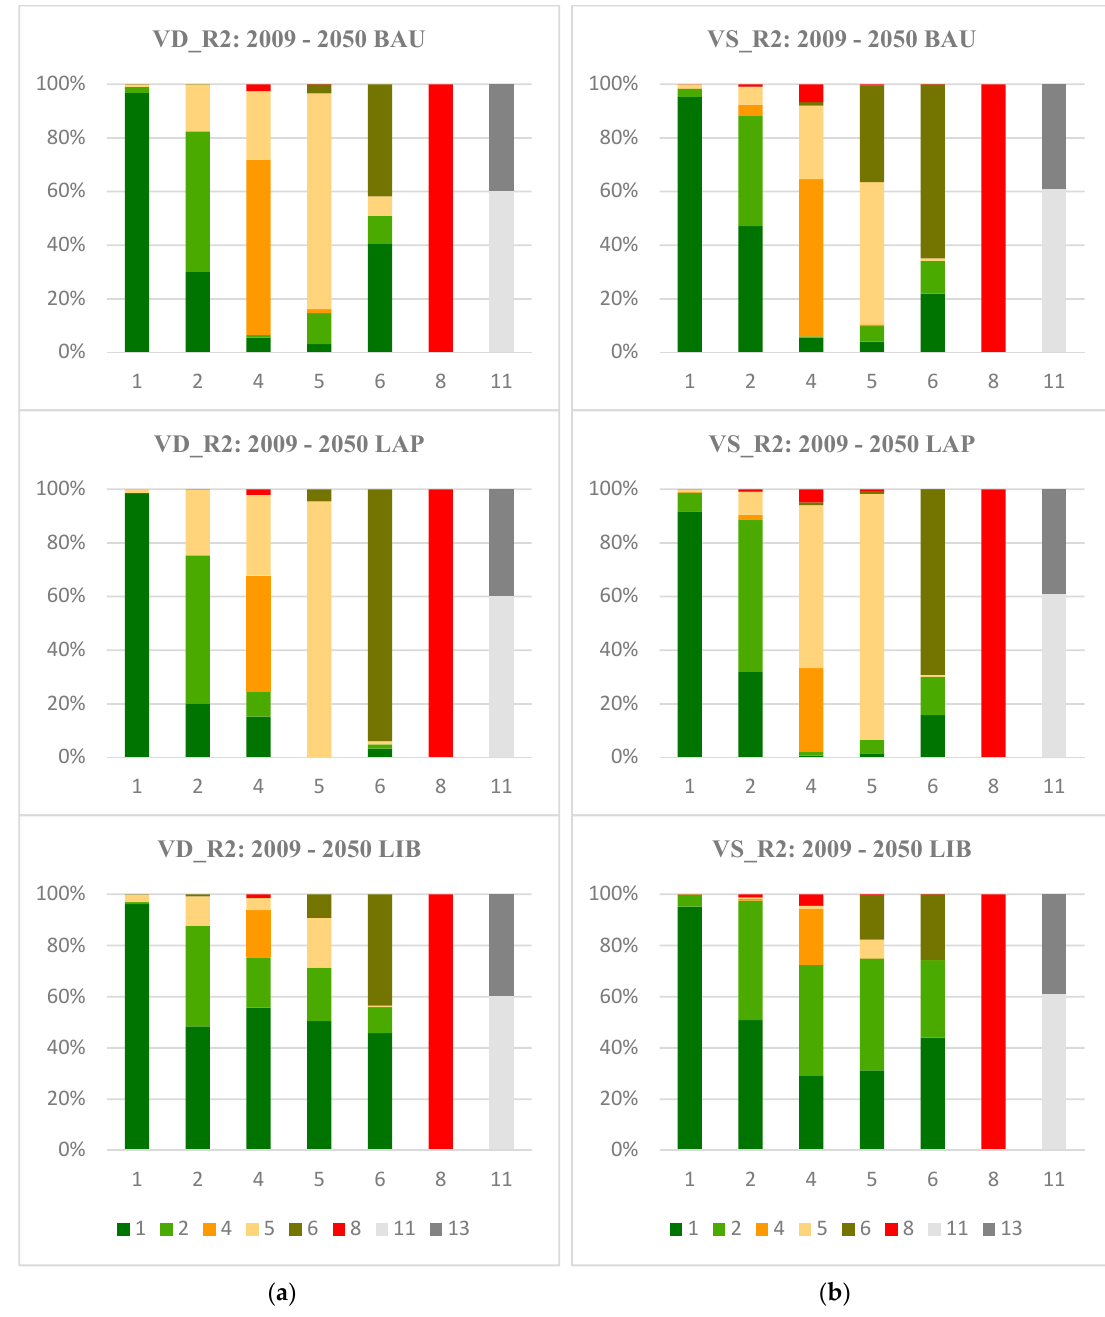
Figure 6. Percentage of land use composition in 2050 (BAU, LAP and LIB scenarios) out of the existent in 2009, in ( a ) VD_R2 and ( b ) VS_R2. Each stacked bar represents the share of land use type in 2050 (BAU, LAP and LIB scenarios) for each land use types observed in 2009. Colours indicate each land use type. The stacked bar percentage information was obtained by cross-tabulation between the observed 2009 and each land use scenario. 1: closed forest; 2: open forest; 4: intensive agriculture; 5: extensive agriculture; 6: shrubland; 8: urban; 11: glaciers and permanent snow; 13: rocks and sand.